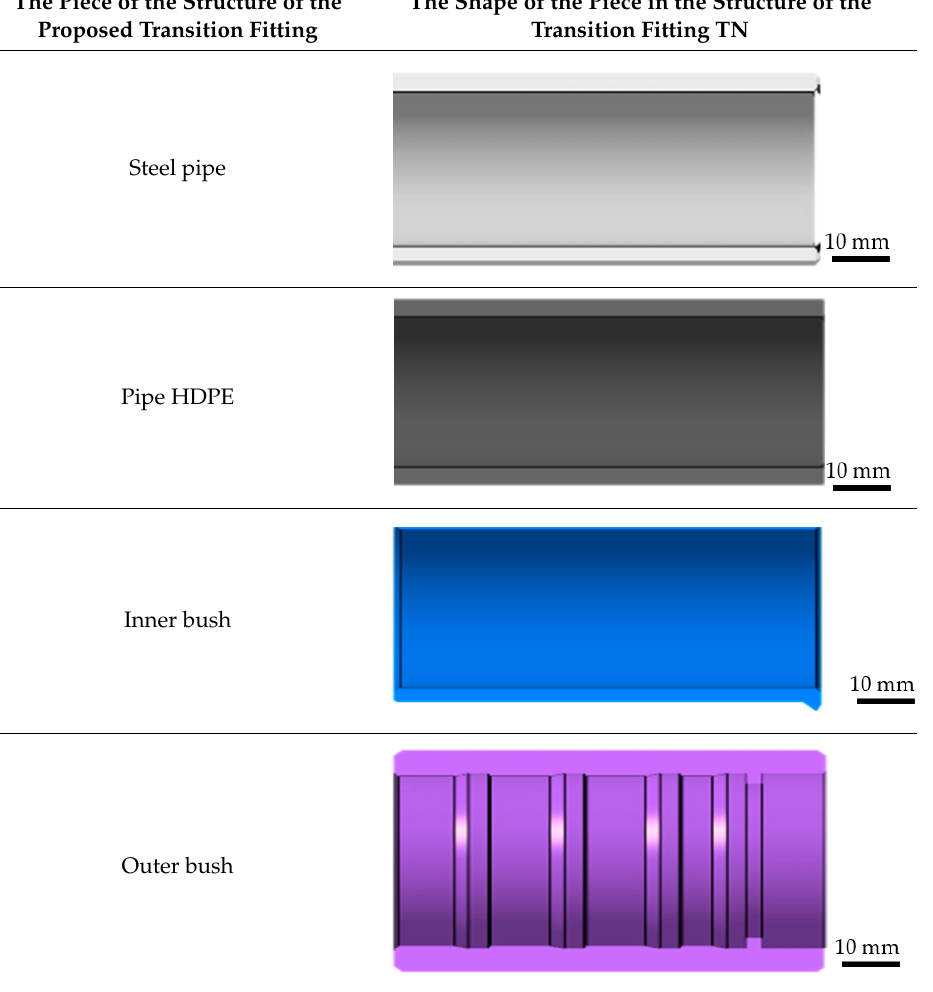
Figure 7. Section through TN transition fitting: 1—HDPE pipe; 2—outer bush; 3—inner bush; 4— welding bead; 5—steel pipe.